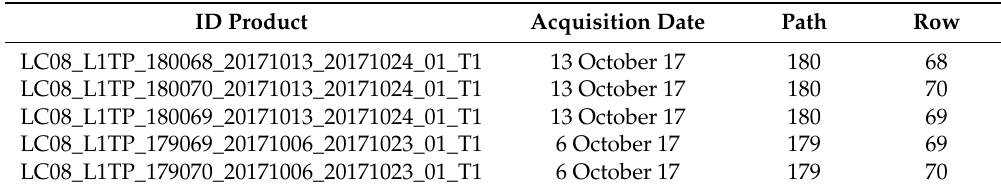
Table 1. Details of the Landsat-8 images used; all images had a resolution of 15